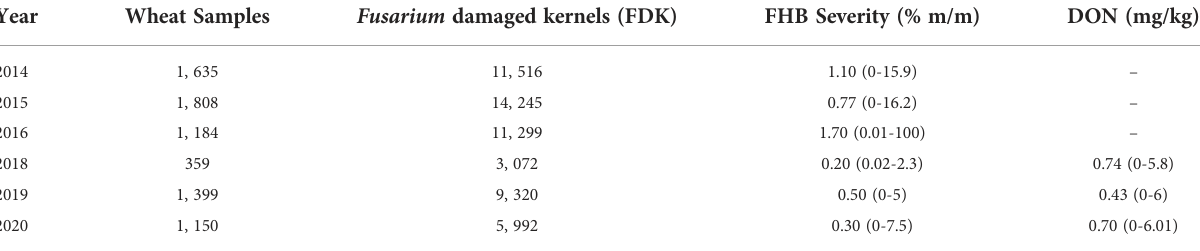
TABLE 2 Total number of wheat samples and Fusarium damaged kernels (FDK) assessed for each test year, and median FHB severity (% m/m) and mean DON (mg/kg) for wheat samples tested by CGC-HSP beginning from 2018-2020. Year Wheat Samples